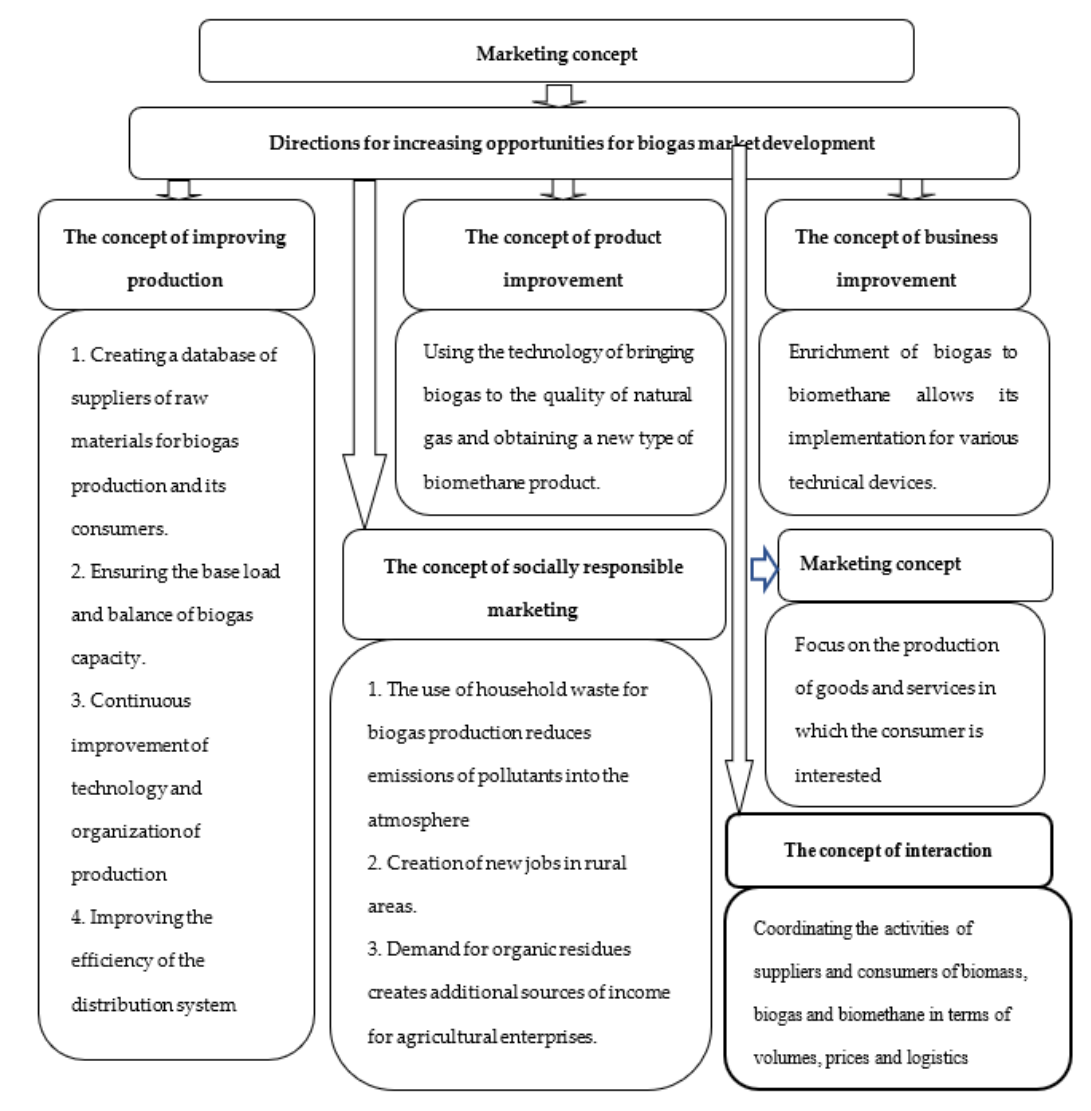
Figure 4. Conceptual model of biogas market development. Source: own elaboration.